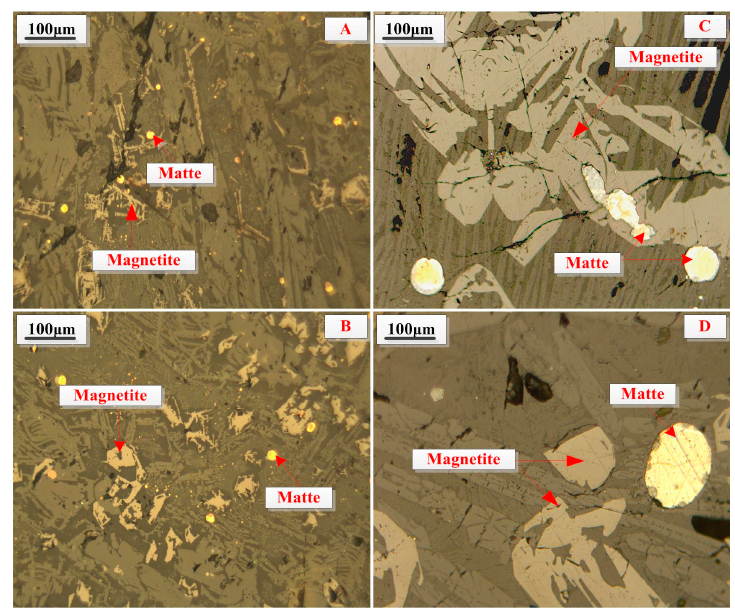
Figure 12. Microstructures of the copper slag (0.45 of binary basicity, blending with 12% of compound additive, modifying at 1350 °C for 120 min and cooling at 1.5 °C/min down to 900 °C): ( A , B ) unmodified slag; and ( C , D ) modified slag.